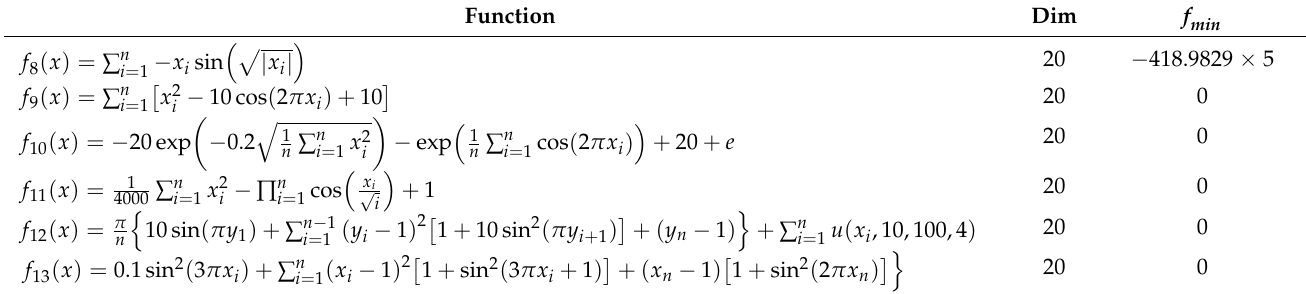
Table 2. Multimodal functions.